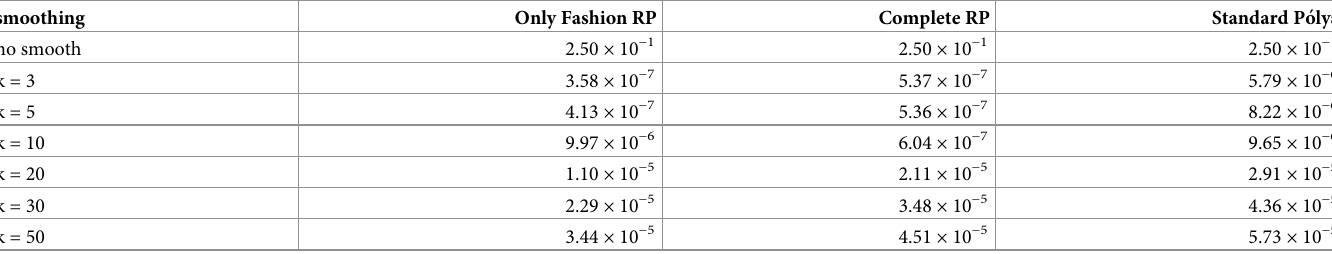
Table 14. “Migration” ( T = 0.5, entire, D = 3 0 , S = 100 slots of equal size): MSE for different levels of